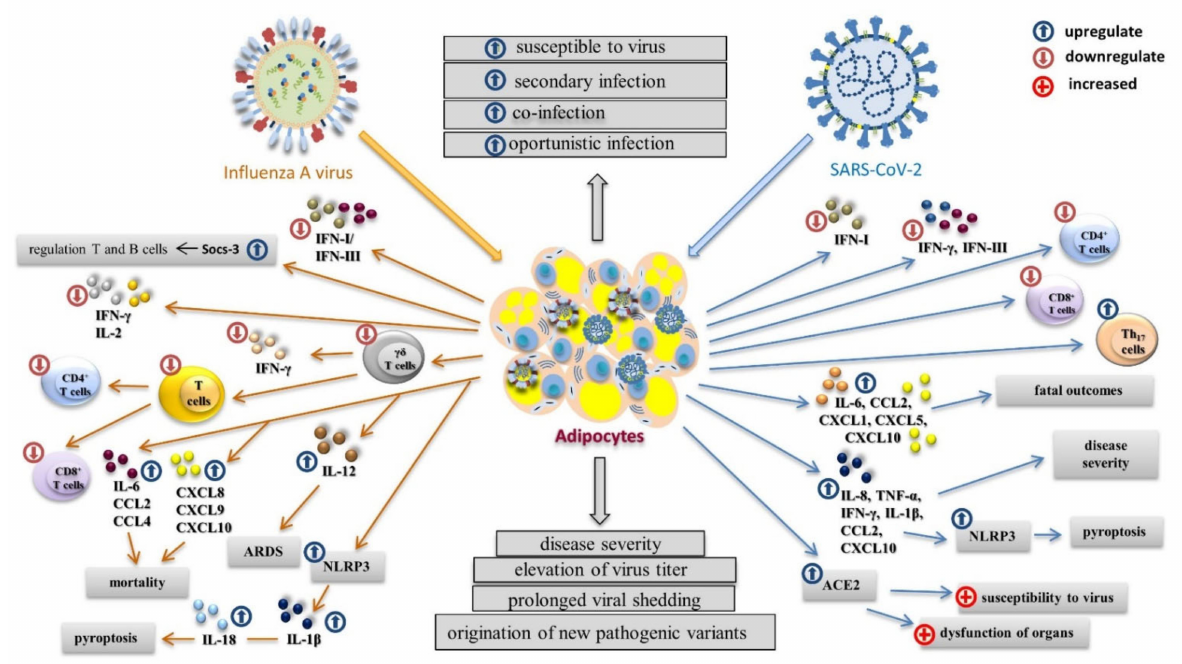
Figure 3. The impact of virus infection on the immune response in obese individuals. With influenza infection, the antiviral response and immune disfunction of adaptive immunity are inefficient due to the chronic production of pro-inflammatory cytokines. The production of IFNs I and IFNs III is delayed or increased, and blood peptin upregulates the suppressor of cytokine signaling-3 (SOCS-3), which regulates the function of T and B cells. The reduced amount and activity of γδ T cells leads to a lower production of IFN- γ and reduced T cell diversity. The influenza virus activates assembly of the pyrin domain-containing protein 3 (NLRP3) inflammasome, which supports the autocatalytic processing of pro-caspase-1 and the subsequent cleavage and secretion of pro- inflammatory cytokines IL-1 β and IL-18, leading to pyroptosis. The development of cytokine storm results in the overexpression of IL-6 and chemokines CCL2, CCL4, CXCL8, CXCL9, and CXCL10. With SARS-CoV-2 infection, the production of IFN- β and IFN- λ is attenuated, and the level of IFN- γ is very low. Concentrations of CD4 + and CD8 + T lymphocytes are reduced and the level of Th17 is increased. SARS-CoV-2 upregulates the expression of five cytokines connected to mortality: IL-6, CCL2, CXCL1, CXCL5, and CXCL10. Activation of the NLRP3 inflammasome with increased levels of TNF- α , IFN- γ , IL-1 β , IL-8, CCL2, and CXCL10 results in pyroptosis. Overexpression of the ACE receptor plays a crucial role in increased susceptibility to SARS-CoV-2, higher infectivity, and the dysfunction of organs. Both influenza virus and SARS-CoV-2 can infect adipose tissue, which can serve as a virus reservoir, prolonging viral shedding and supporting the origination of new pathogenic